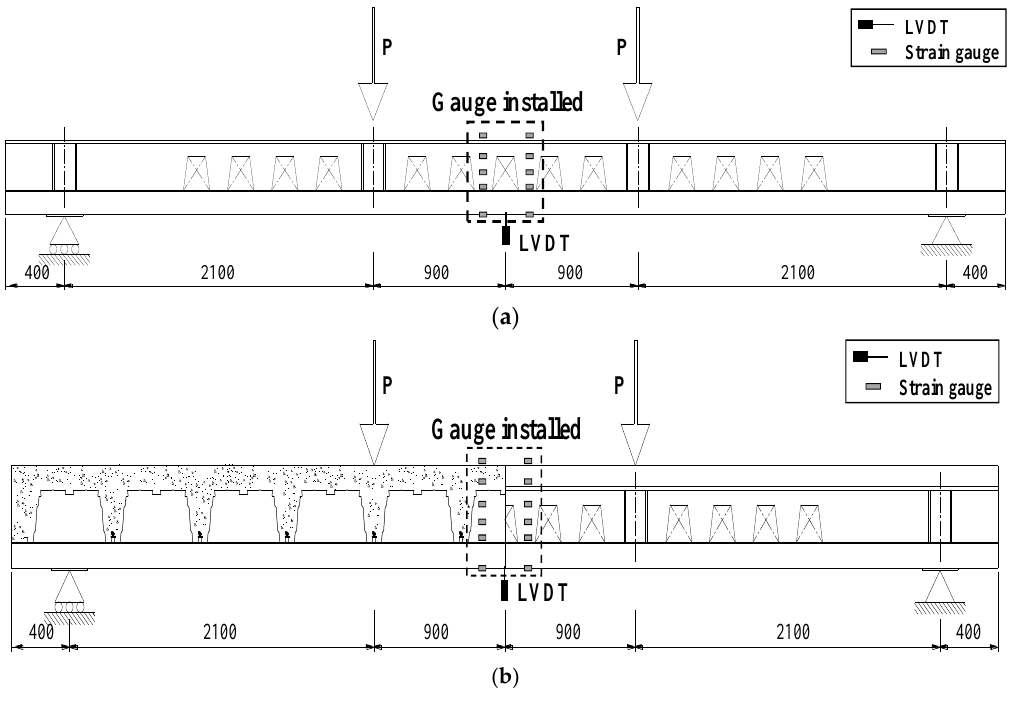
Figure 6. Schematic test setup: ( a ) non-composite specimens; ( b ) fully composite specimens.